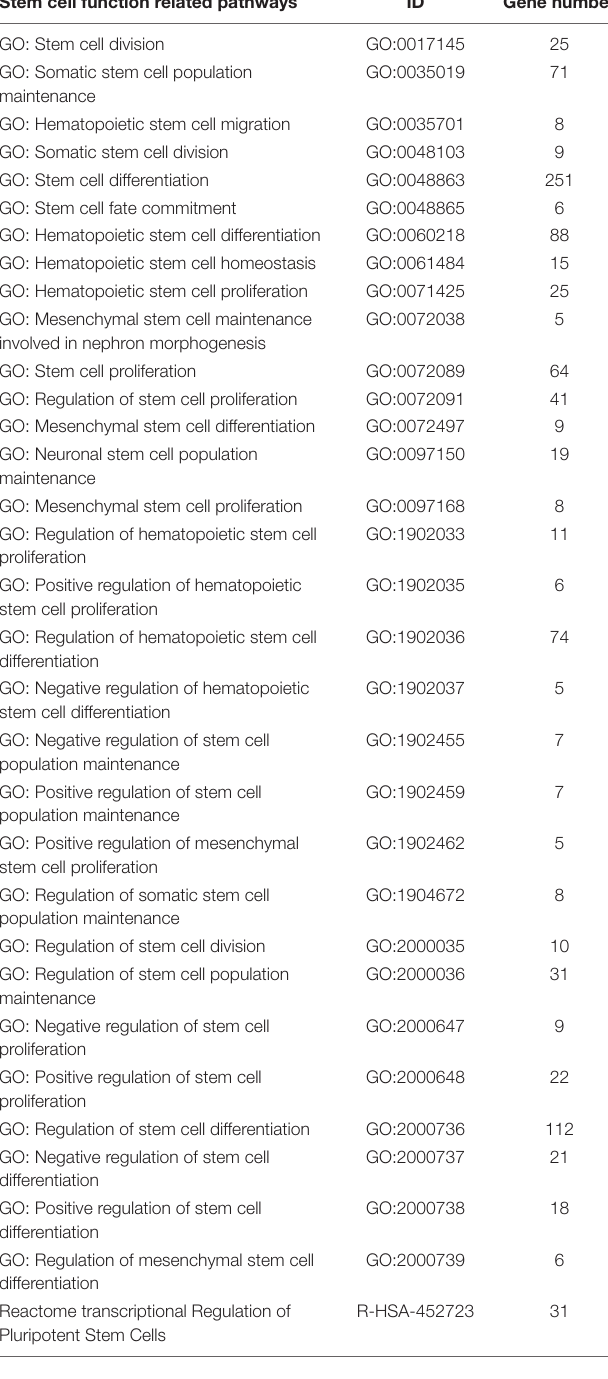
TABLE 1 | Clinical features of the osteosarcoma samples in the Therapeutically Applicable Research to Generate Effective Treatments (TARGET) and Gene Expression Omnibus (GEO) databases.